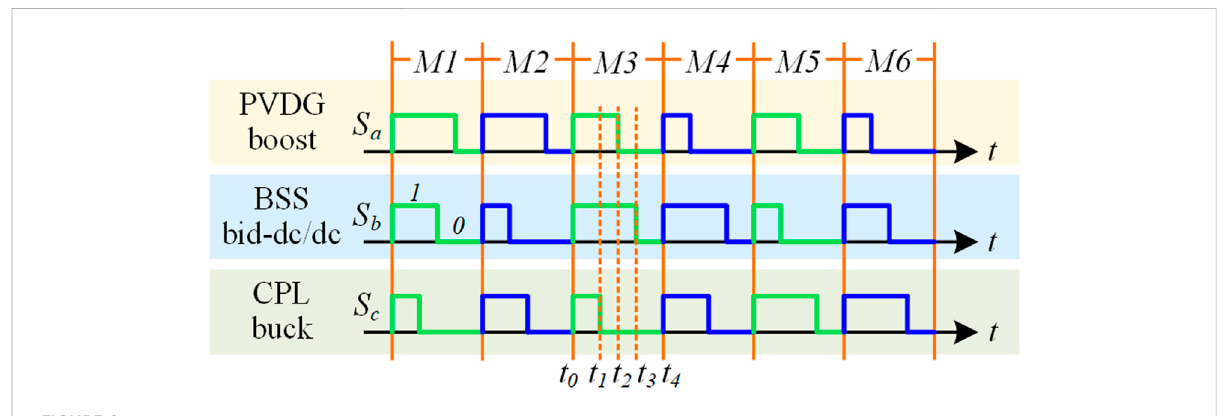
FIGURE 2 Switching sequence diagrams and six stable operation modes.